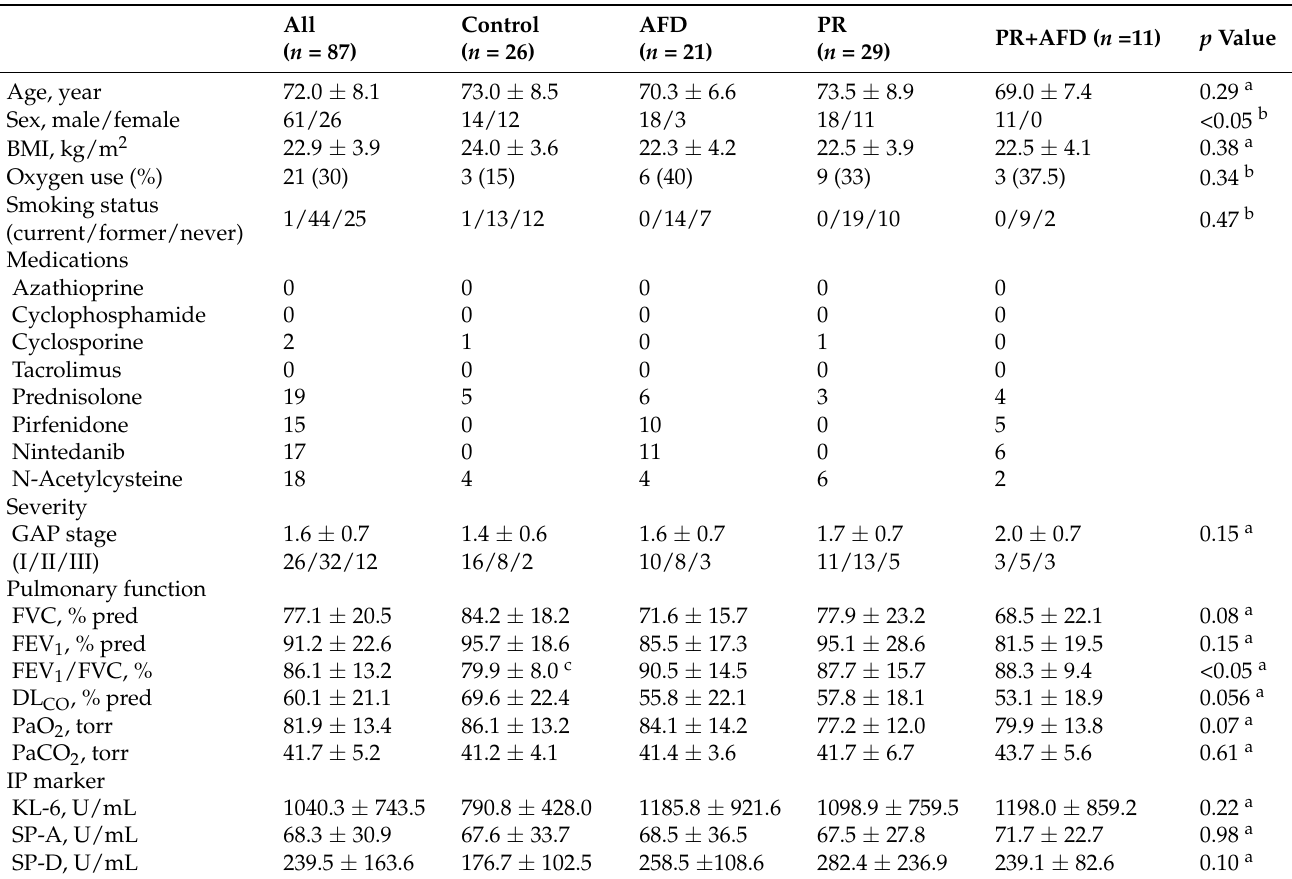
Table 1. Baseline characteristics of each group.